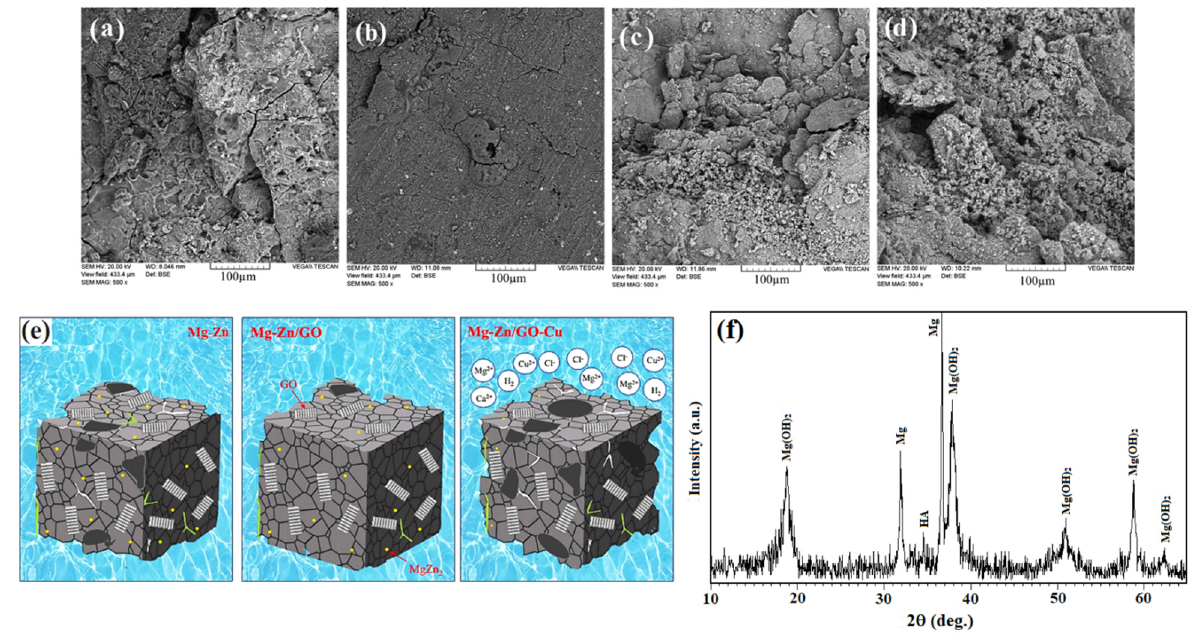
Figure 8. SEM images of the samples ( a ) MZ, ( b ) MZ/GO (G), ( c ) MZ/1GO-Cu, and ( d ) MZ/2GO-Cu composites after immersion in SBF solution for 7 days and ( e ) schematic model for corrosion process of MZ, MZ/GO, and MZ/2GO-Cu composites, ( f ) X-ray diffraction patterns of MZ/GO-Cu after soaking in SBF for 7 days.